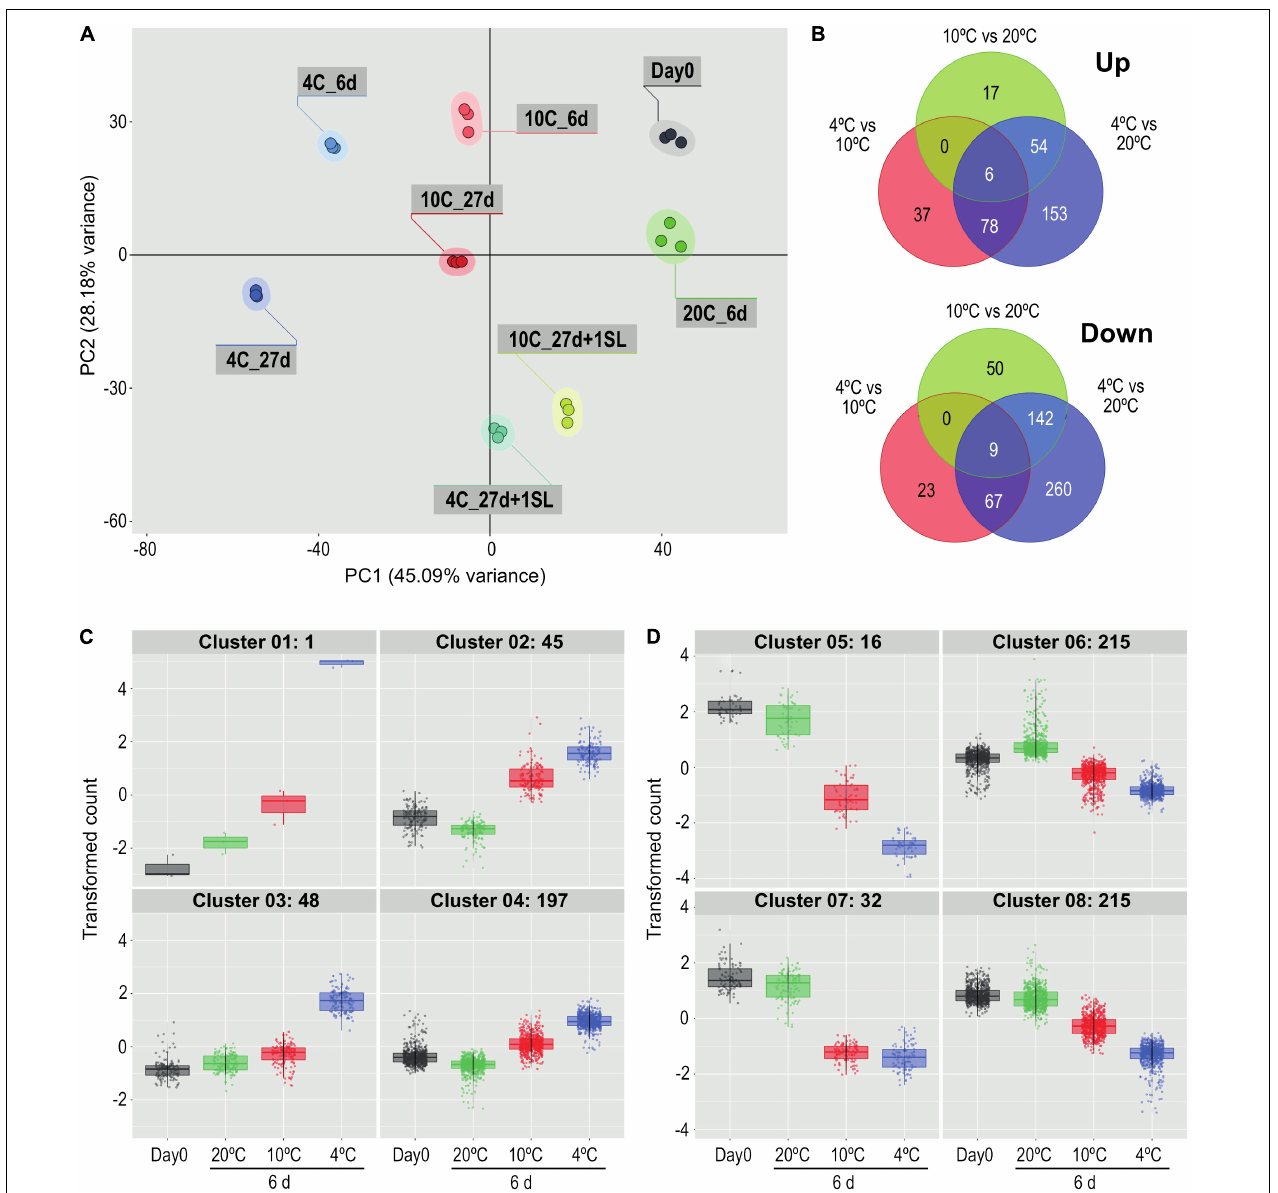
FIGURE 2 | Comparison of the effects of storage at different temperatures on the ripe tomato fruit transcriptome. (A) Principal component analysis of transcriptome profiles based on the 50 most variable genes in each pairwise comparison (total of 720 most variable genes), showing changes during storage at 4, 10, or 20 ◦ C. An additional 1-day period at a shelf-life (SL) temperature of 20 ◦ C was also included after 27 days. (B) Venn diagrams showing numbers of genes differentially expressed at 4, 10, and 20 ◦ C at 6 days of storage. For each pairwise comparison, the count values in the lower temperature treatment were compared with those in the higher temperature treatment. (C,D) Hierarchical cluster analysis of the gene sets that were up-regulated (291) and down-regulated (478) from the entire blue circles of (B) obtained from the 4 ◦ C versus 20 ◦ C comparison. Expression patterns were clustered into four groups each for up-regulated (C) and down-regulated (D) genes. Genes were considered differentially expressed if they had a mean count in all compared samples of 200 or more, an adjusted P -value of 0.01 and > 3-fold increase or